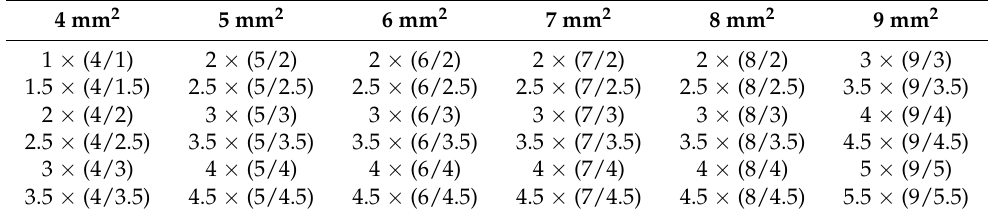
Table 2. Setting of contact area in fracture model: the same contact area and different cross-sections.